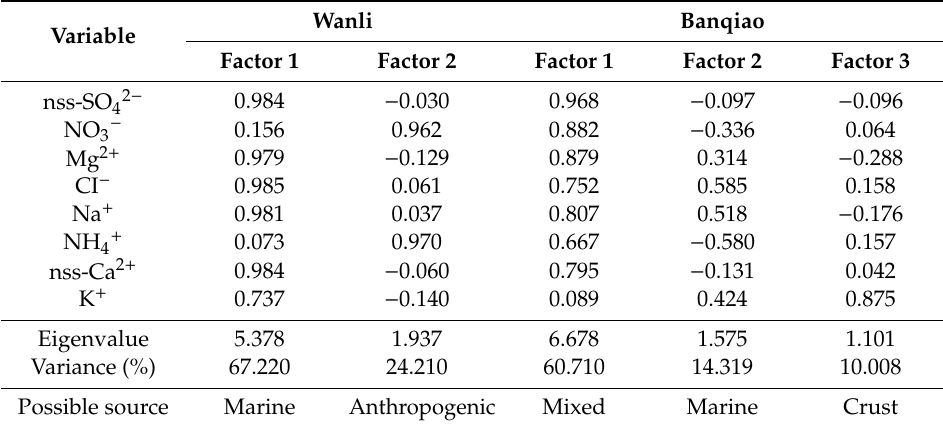
Table 6. Factor analysis results of